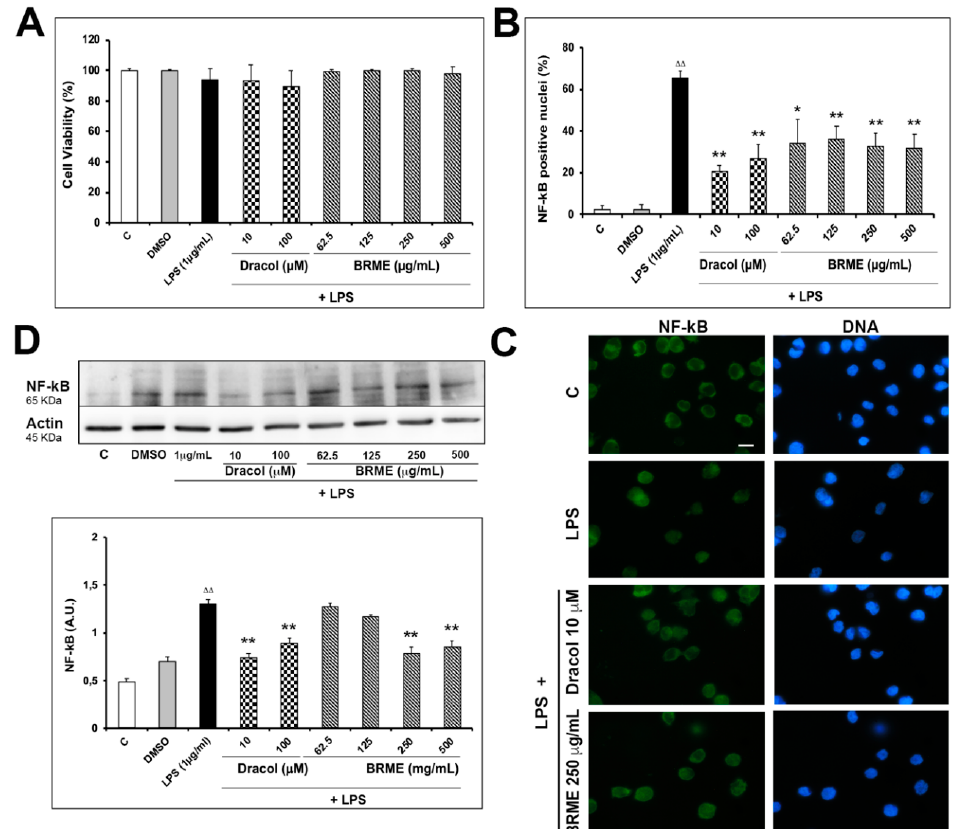
Figure 4. LPS-induced NF-kB cellular level is prevented by treatment with BRME and Dracol . ( A ) E ff ect of 24 h treatment with Dracol and BRME in the presence of 1 µ g / mL LPS on THP1 viability evaluated by MTT assay. Values are expressed as percentage of untreated cells (control). DMSO, dimethyl sulfoxide. ( B ) Quantification of NF-kB positive nuclei after treatment with Dracol and BRME in the presence of LPS, and ( C ) their representative images. ( D ) The correspondent Western blotting in control and treated samples as indicated and quantitative analysis of the bands. Scale bar = 10 µ m. Values compared to positive control (LPS) and control cells are expressed as mean ± SD from at least three